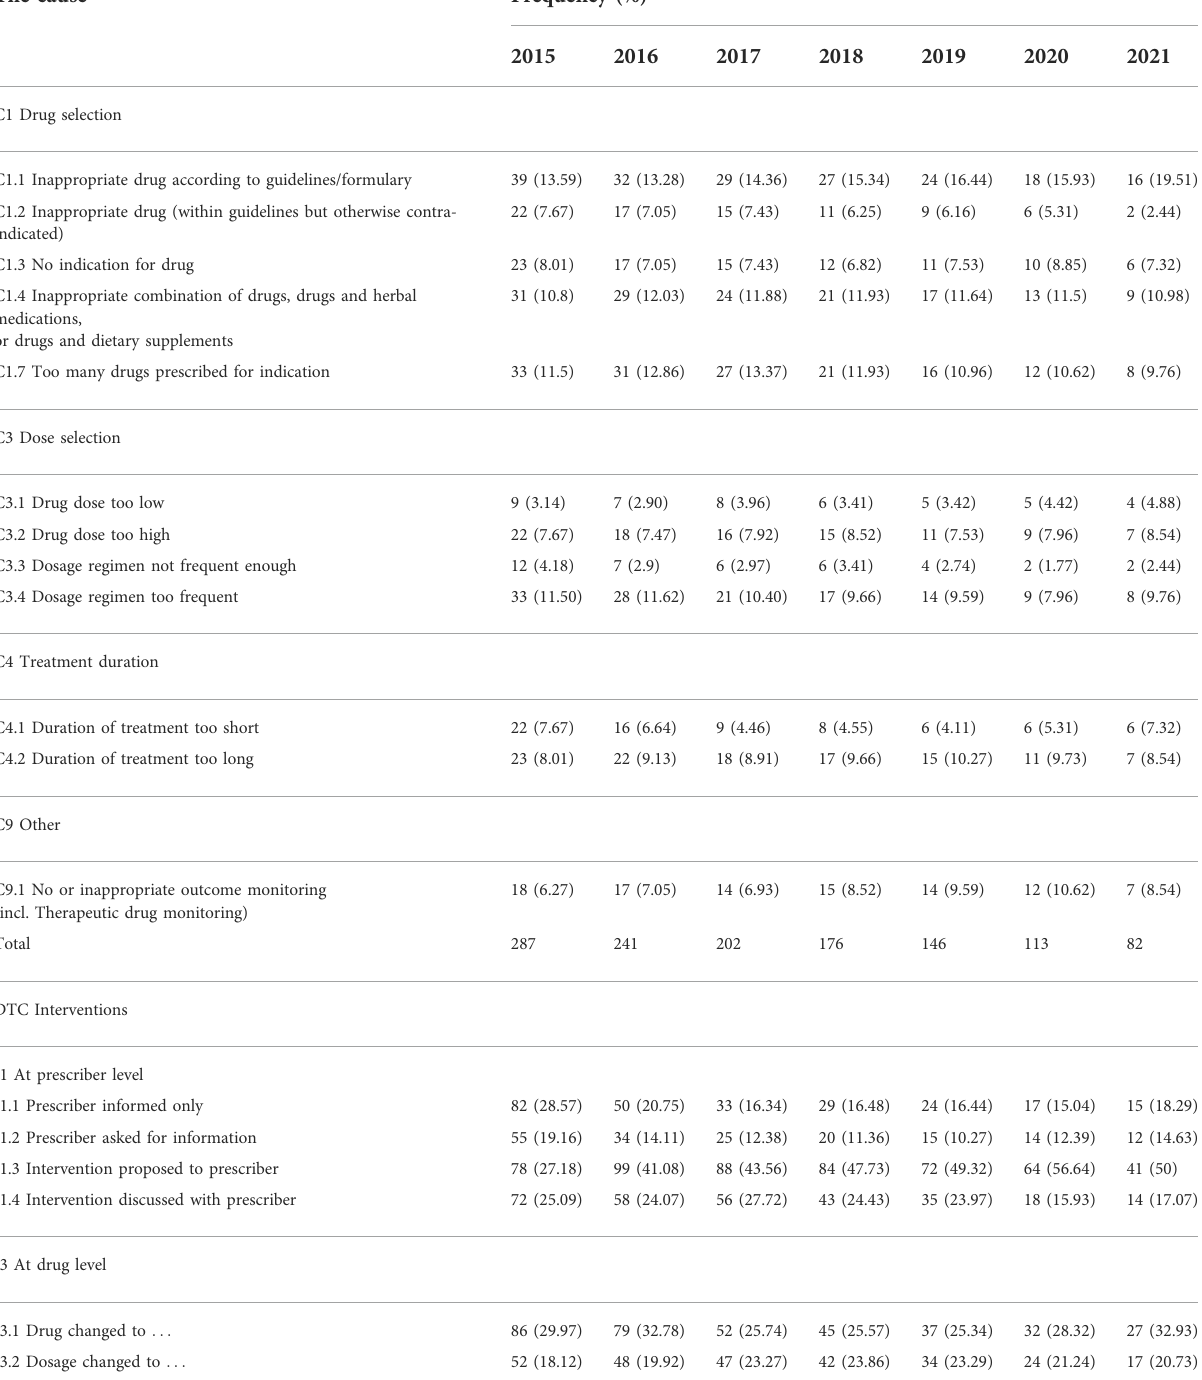
TABLE 1 Types of irrational drug uses and DTC interventions. The